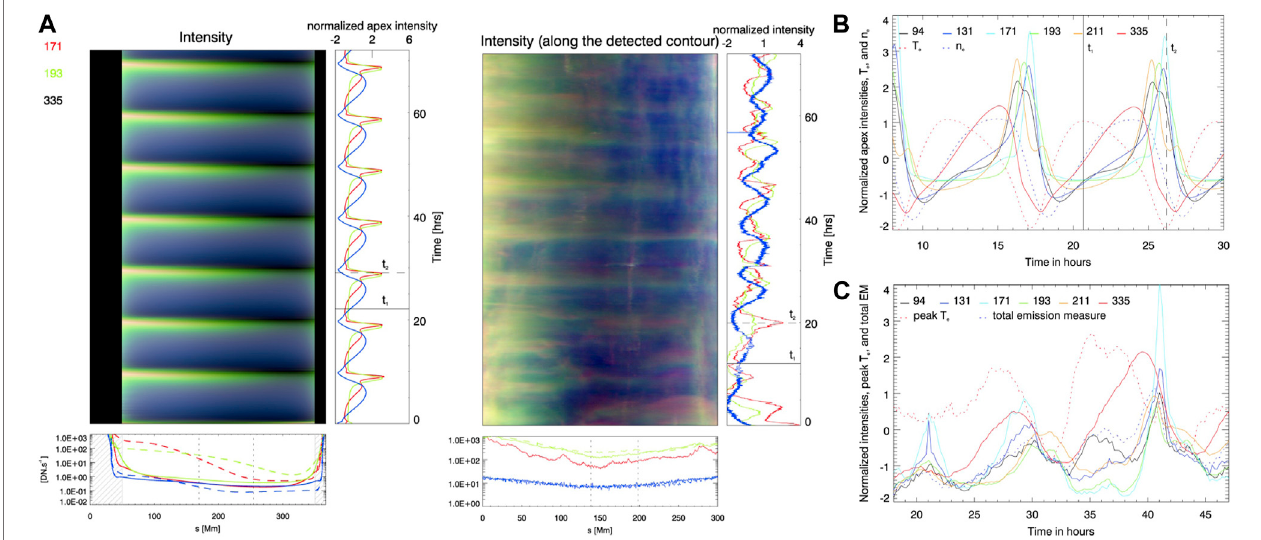
FIGURE 6 | Long period-intensity pulsations in the SDO /AIA coronal channels and comparison with simulations. (A) Simulation of EUV intensities from a 1D hydrodynamical simulation of TNE. Middle: EUV intensities for the main loop bundle studied in Froment et al. (2015). See Froment et al. (2018) for more details. Both panels are adapted from Figure 17 of that paper. (B) Synthetic intensities from a 1D hydrodynamic simulation. The dotted lines represent the temperature and the density, respectively. (C) Intensities from the observations. The dotted lines represent the peak temperature of the DEM and the total emission measure, respectively. Both panels are adapted from Froment et al. (2017) (Figures 9, 12, © AAS. Reproduced with permission). See the original papers for more